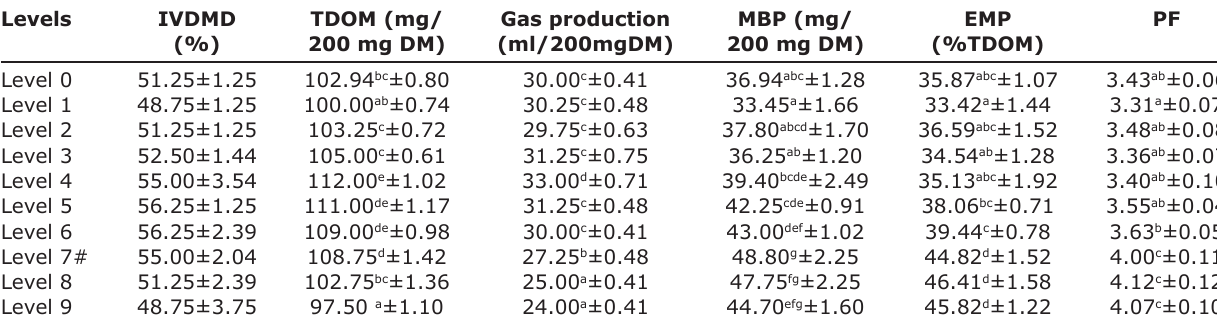
Table 6: In vitro degradability variable of complete feed comprising of ADF replacement at variable levels by lime treated olive cake